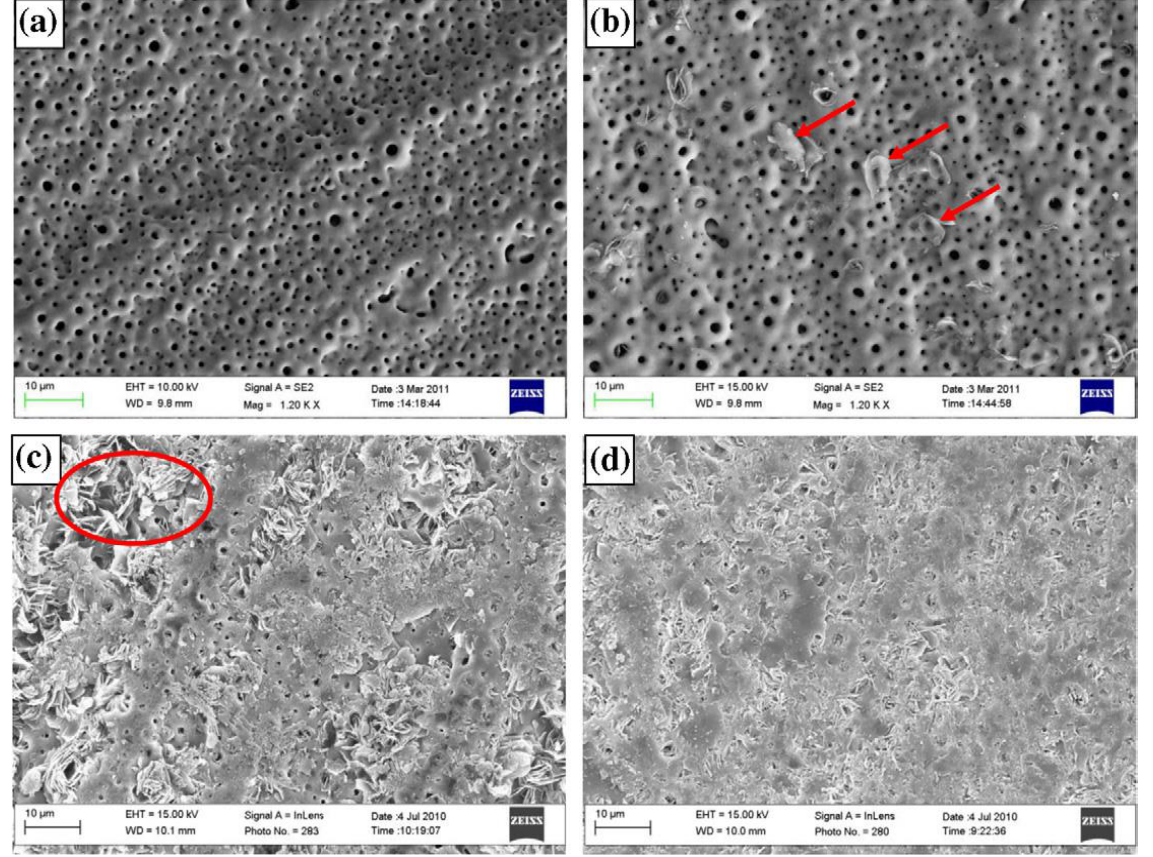
Figure 20. Surface morphologies of anodic films formed in the solutions of 10 g/L NaOH and 18 g/L Na 2 SiO 3 ( a ) without 8-HQ, with addition of ( b ) 2 g/L 8-HQ, ( c ) 5 g/L 8-HQ and ( d ) 8 g/L 8-HQ under current density 40 mA/cm 2 , frequency 2000 Hz, duty cycle 20% and anodizing time 3 min. Adapted from [234] with permission from Elsevier. Adapted from [234] with permission from